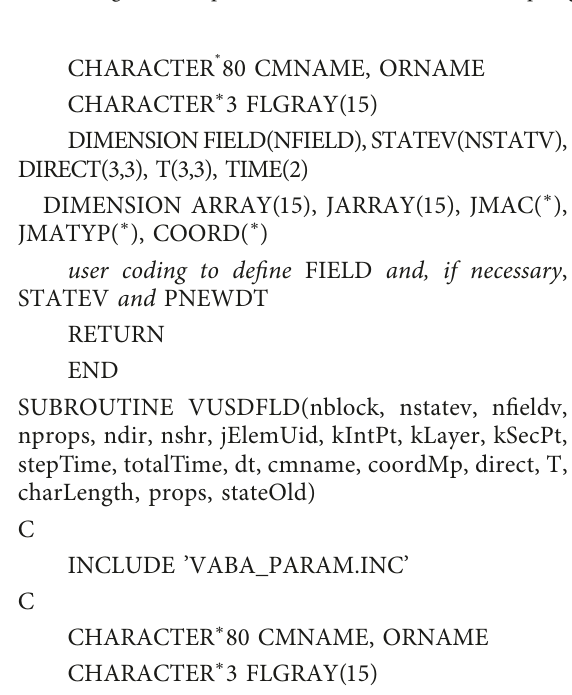
Figure 8: The ground displacement curves with different dip angles for the reverse fault in sand: (a) 45 ° , (b) 60 ° , (c) 75 ° , and (d) 90 °